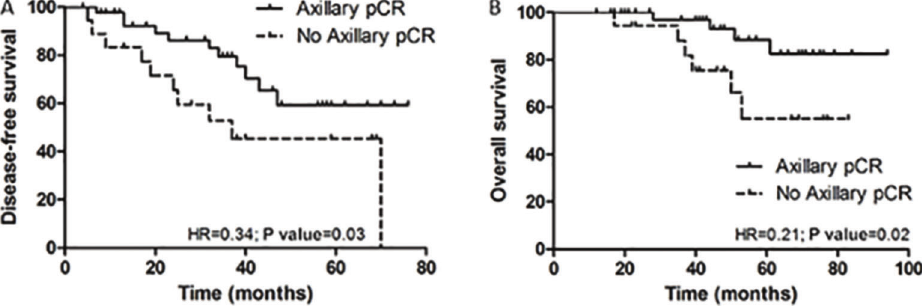
Figure 2. Disease-free ( A ) and overall ( B ) survival of the 63 patients with HER2-positive breast cancer treated with neoadjuvant chemotherapy with trastuzumab by axillary pathologic complete response (pCR) status. One patient died during neoadjuvant chemotherapy and was excluded from the analyses and 1 patient was excluded because the data of axillary involvement was not available. Log-rank test was used to compare the curves. HR: hazard